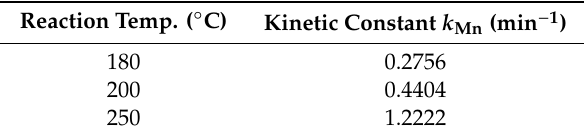
Table 2. Kinetic constant of decreasing number average molecular weight ( M n ).